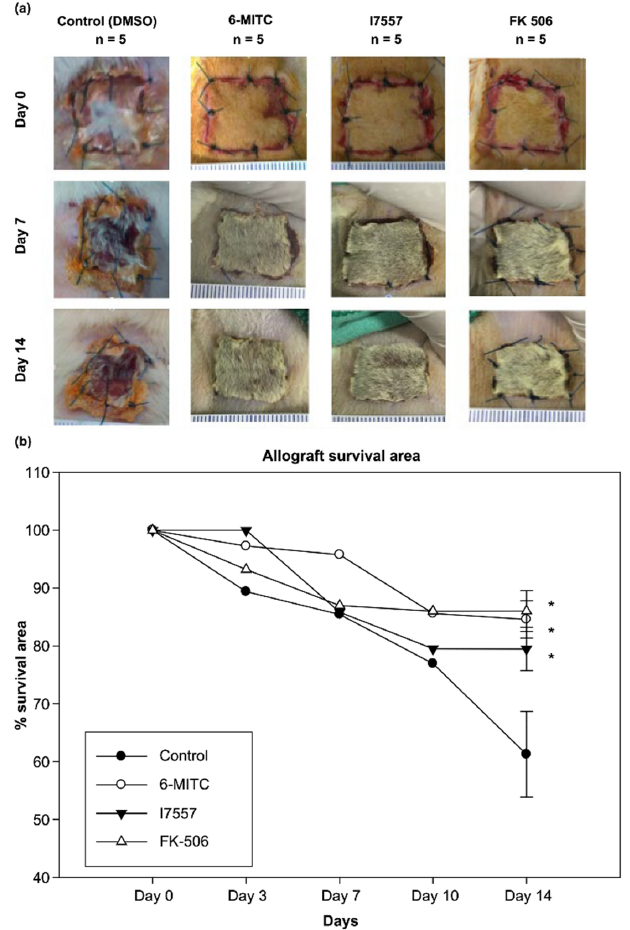
Figure 6. ( a ) 6-MITC and I7557 maintains skin allograft integrity; ( b ) 6-MITC and I7557 prolongs skin allograft survival by maintaining the survival area (* p < 0.05).